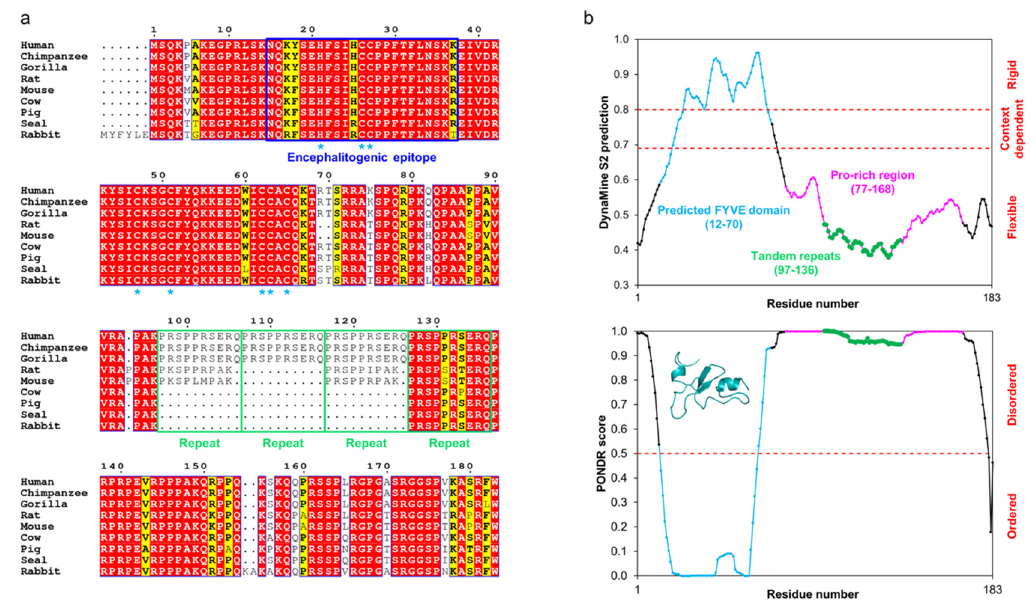
Figure 4. The conservation and predicted flexibility of MOBP isoform 1. ( a ) Sequence alignment of mammalian MOBPs generated using ESPript [66]. MOBP is highly conserved throughout mammals and especially within primates. Residue numbering corresponds to human MOBP. The residues predicted [48] to interact with Zn 2 + in the putative FYVE domain have been indicated with blue asterisks. The tandem repeats within the Pro-rich region are indicated with green outlines. ( b ) DynaMine [132] (top) and PONDR [133] (bottom) predict human MOBP to be mostly disordered, with a folded N-terminal FYVE domain. The various compositional regions have been indicated. The structure in the PONDR inset represents the Phyre 2 [134] prediction of the FYVE domain.